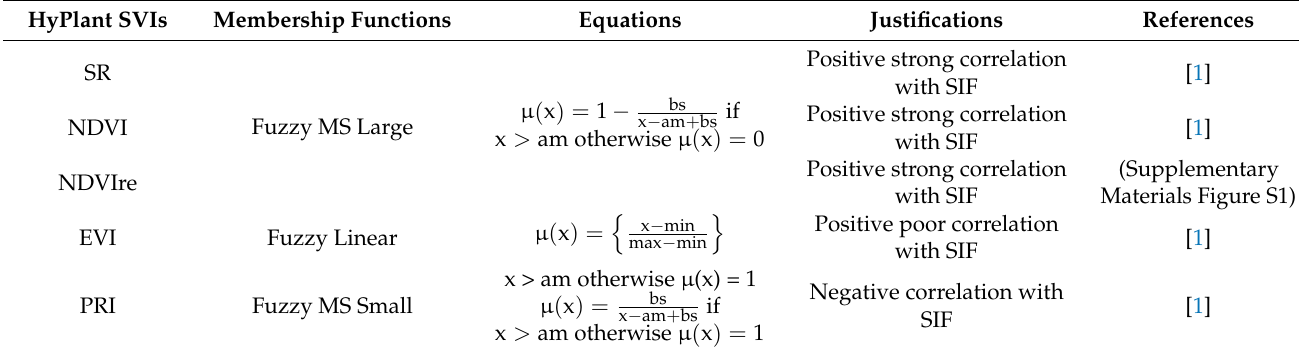
Table 2. The mathematical equations of membership functions and justifications for considering a membership transforma- tion function for individual HyPlant derived